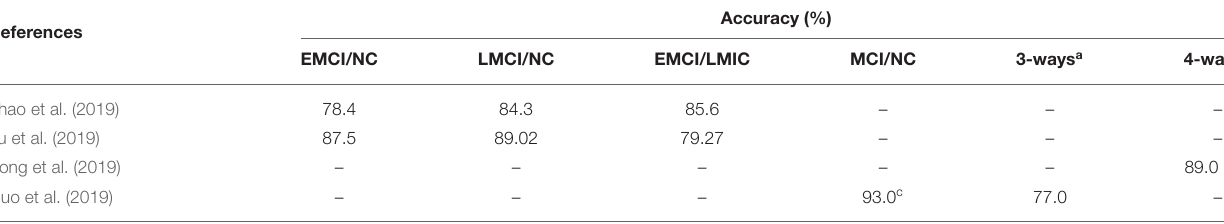
TABLE 4 | The classification performance of papers for MCI